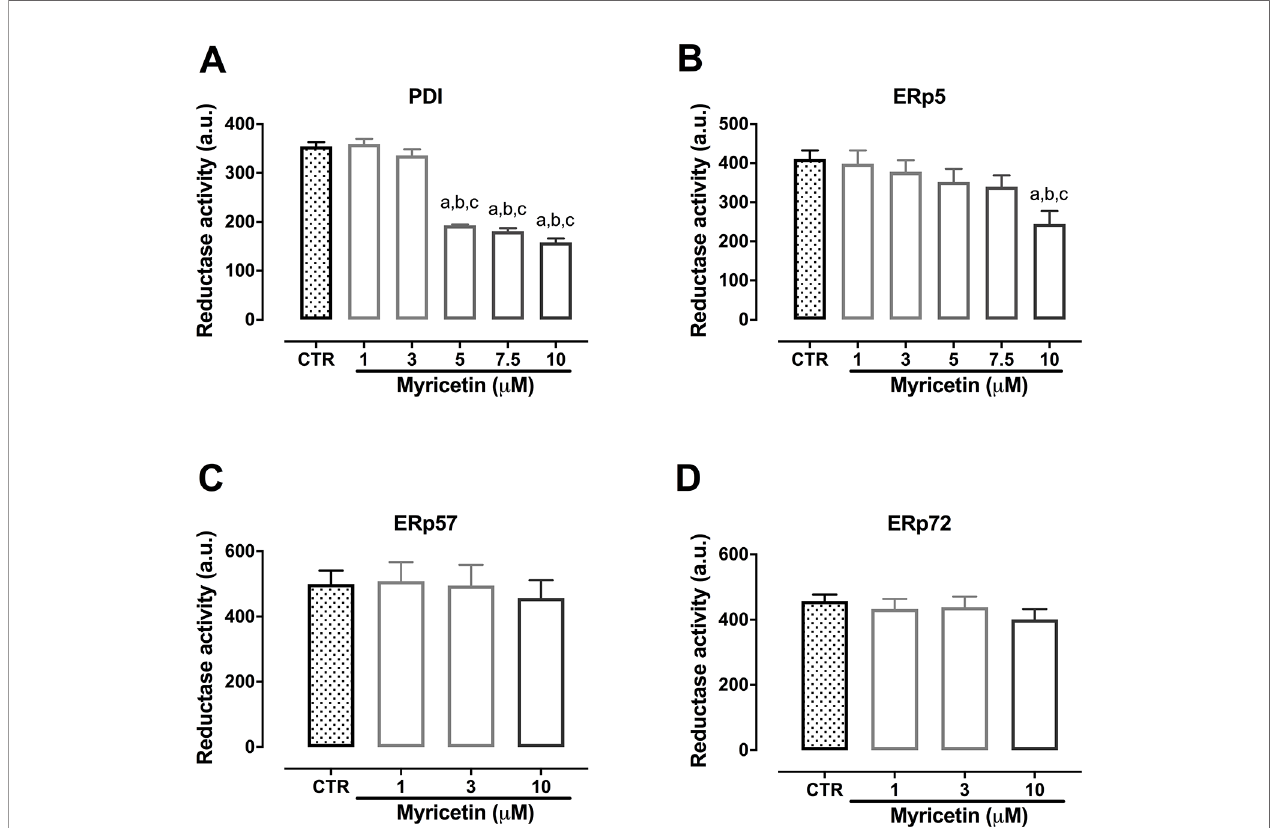
FIGURE 6 | Myricetin inhibits reductase activity of PDI and ERp5. Recombinant proteins were incubated with myricetin (0.01 to 10 m M) in a black 96-wells plate for 10 min followed by addition of DTT (5 m M) and Di-E-GssG (200 nM). Fluorescence was read every 30 s for 30 min. Final point fl uorescence at 30 min is shown for ERp5 (A , B) , PDI (C , D) , ERp72 (E , F) , and ERp57 (G , H) . Data represent at least three independent experiments run at least in duplicate and error bars indicate SEM. a p < 0.05 vs fi rst column of graph. b p < 0.05 vs second column of graph. c p < 0.05 vs third column of